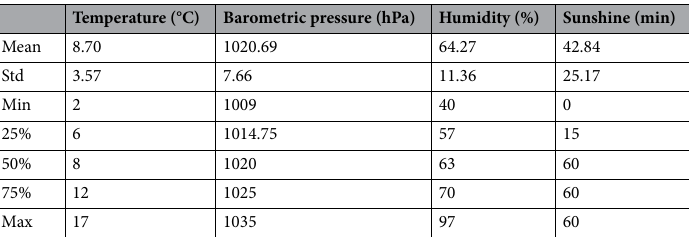
Table 1. Descriptive statistical for weather data. Minutes of sunshine are minutes of a full